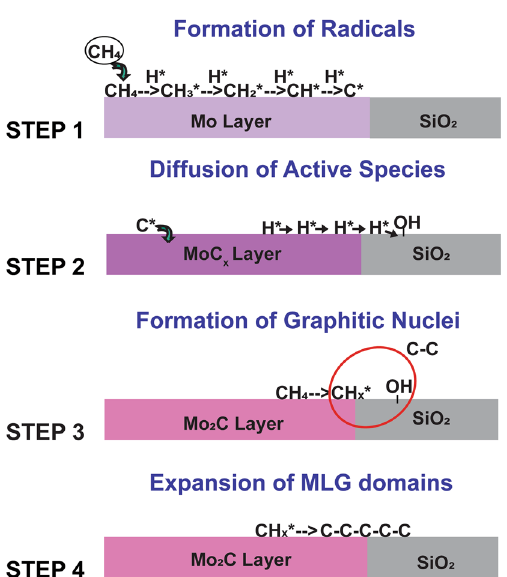
Figure 2. ( b ) Schematic image after CVD process is represented, where left side shows the MLG deposition from interface. SEM image after CVD process showing the cross-section from top view ( a ) Mo 2 C/SiO 2 interface with dotted circle (left), ( c ) step fully covered with only Mo 2 C (Right) and ( d ) full view of the same step with elemental contrast mode imaging, in which MLG growth is shown around the left side of step with black contrast, and no graphene growth around right side of step with light contrast. ( e ) The Raman spectra after CVD process shows the deposition of MLG layers due to presence of D, G and 2D peaks.